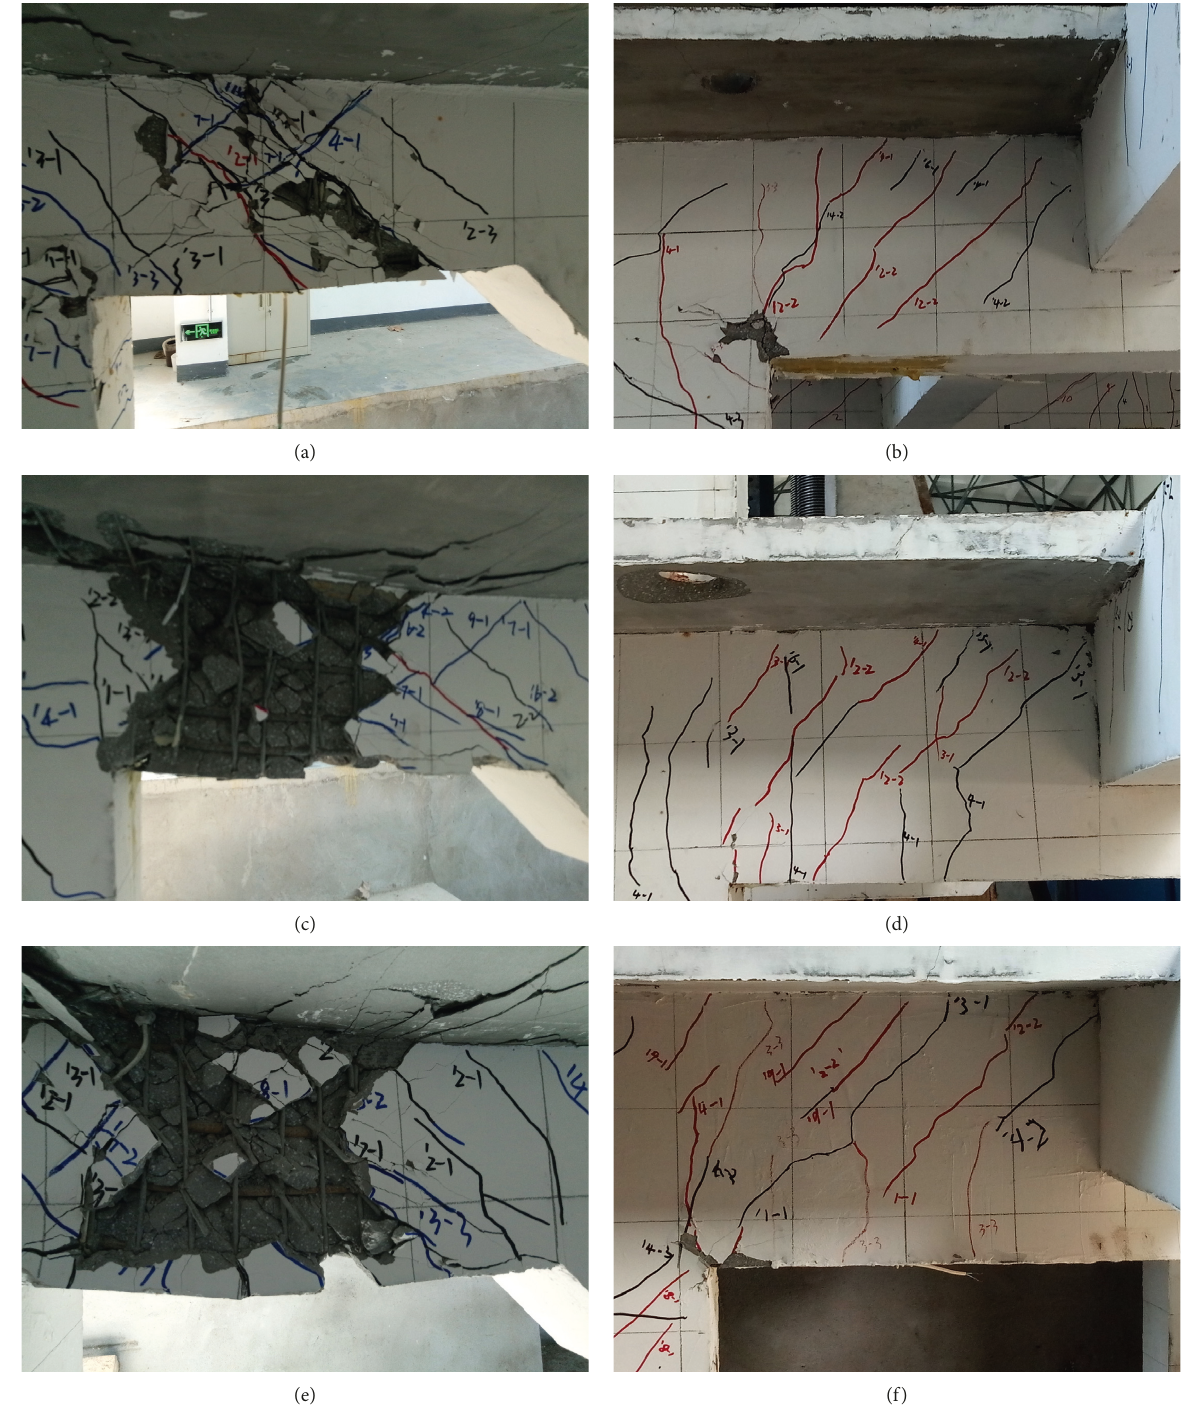
Figure 8: Failure of the SCBs at the end of the test. (a) The ED segment of the SCB at the third storey. (b) The LB segment of the SCB at the third storey. (c) The ED segment of the SCB at the second storey. (d) The LB segment of the SCB at the second storey. (e) The ED segment of the SCB at the first storey. (f) The LB segment of the SCB at the first